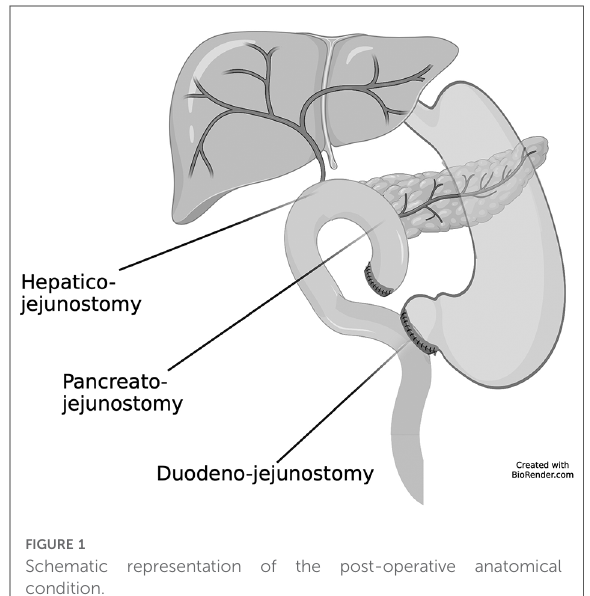
FIGURE 1 Schematic representation of the post-operative anatomical